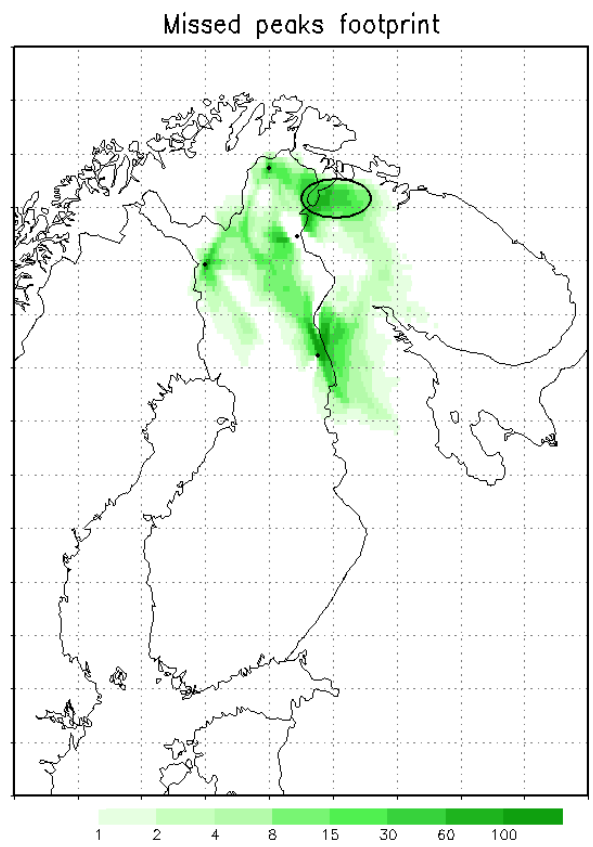
Figure 10. Footprint of the major model-measurement differences (cmdl-cobs) of SO2 concentration at monitoring sites (black dots), mean over 2006. The drawn quantity is the likelihood of the revised emission to be under-estimated. Presence of hot-spots around individual stations is an artefact originating from the low density of the observational network.